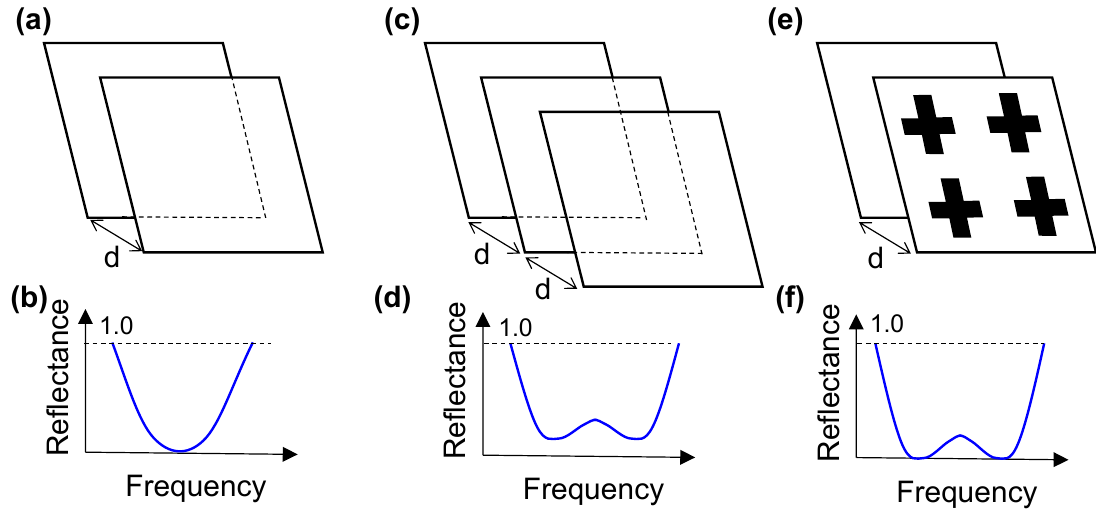
Figure 1. Schematic illustrations and reflectance of resonant absorbers: ( a , b ) the Salisbury screen; ( c , d ) the Jaumann absorber; and ( e , f ) the circuit analog CA absorber. “d” represents the quarter-wavelength gap [6].